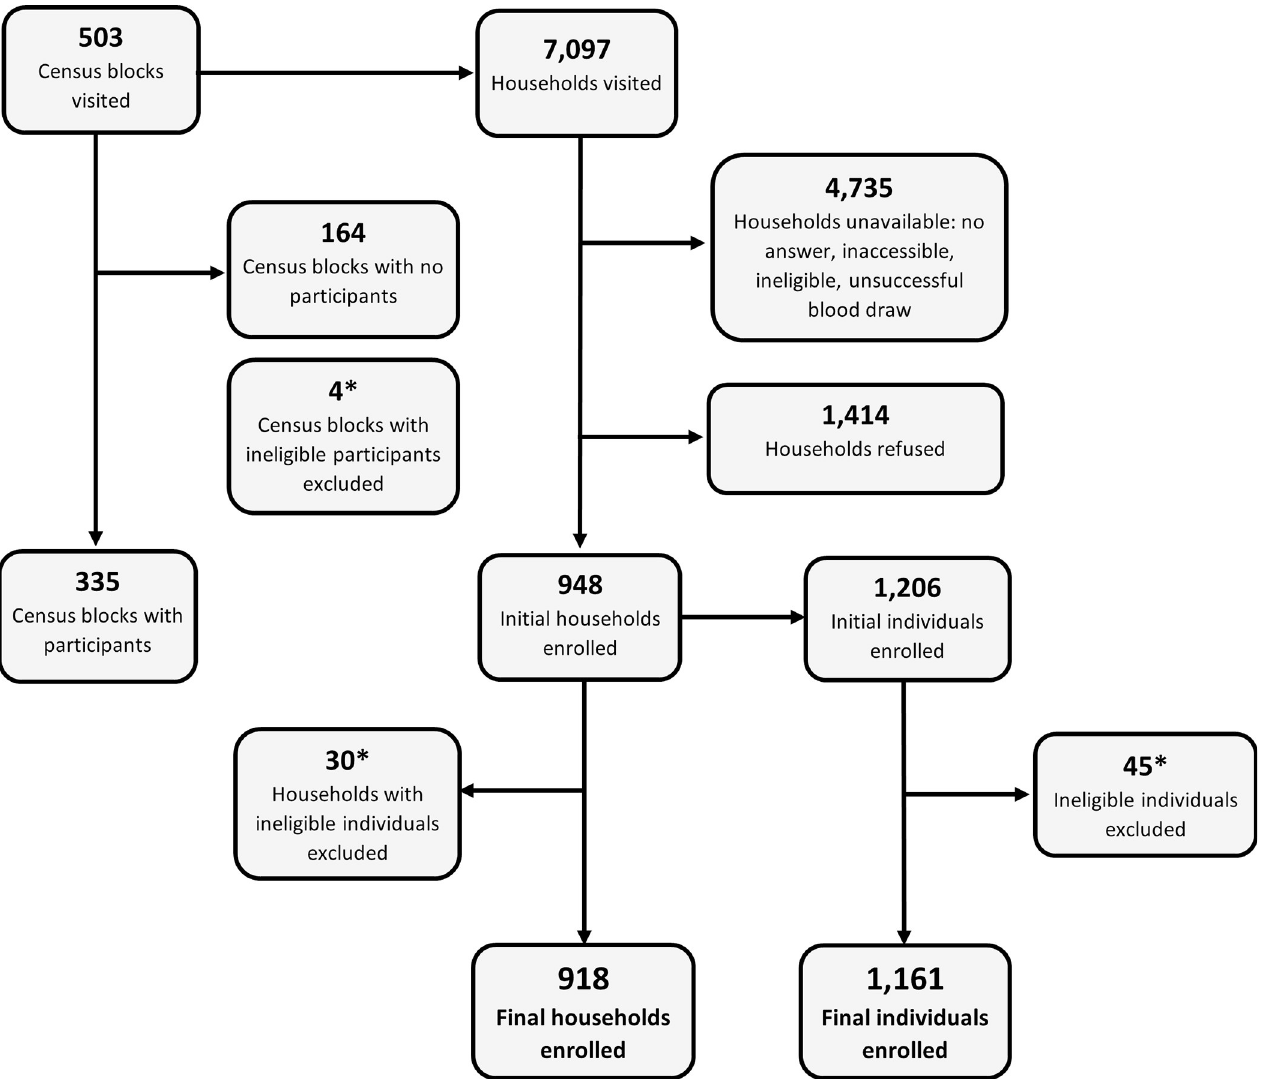
Fig 1. Sampling and Enrollment Diagram for the Leptospirosis Serosurvey in USVI, March 2019. � Post-survey preliminary data cleaning and analysis revealed 45 participants who did not meet the eligibility criteria and were enrolled in error, resulting in their exclusion from final analysis. Thirty households and four census blocks with only ineligible individuals enrolled were removed from the final counts. highest titer of � 1:400, of which all were single serogroup reactions. One participant had a highest titer of 1:3200 to serogroup Pyrogenes, two had a 1:1600 highest titer to serogroups Australis and Ballum, three had 1:800 highest titers to serogroups Djasiman (n = 1) and Ictero- haemorrhagiae (n = 2), and two had 1:400 highest titers to serogroups Icterohaemorrhagiae and Pyrogenes (S2 Table). Among the 83% of seropositives (n = 39) with a highest titer of 1:100 to 1:200, 20% (n = 8) reacted to multiple serogroups. Among all seropositive participants, serogroup Icterohaemorrhagiae was the most common highest reacting serogroup (45%, n = 21), followed by serogroup Australis (26%, n = 12). Highest titers were also observed to ser- ogroups Canicola (n = 7), Pyrogenes (n = 5), Tarrasovi (n = 4), Autumnalis (n = 2), Bataviae (n = 2), Djasiman (n = 2), Ballum (n = 1), and Sejroe (n = 1).